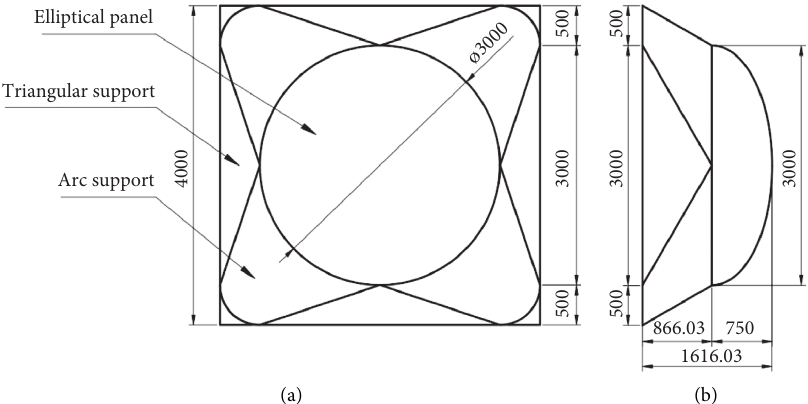
Figure 5: Elliptical blast-resistant door with the combined structure (EBD; unit: mm): (a) front view and (b) side